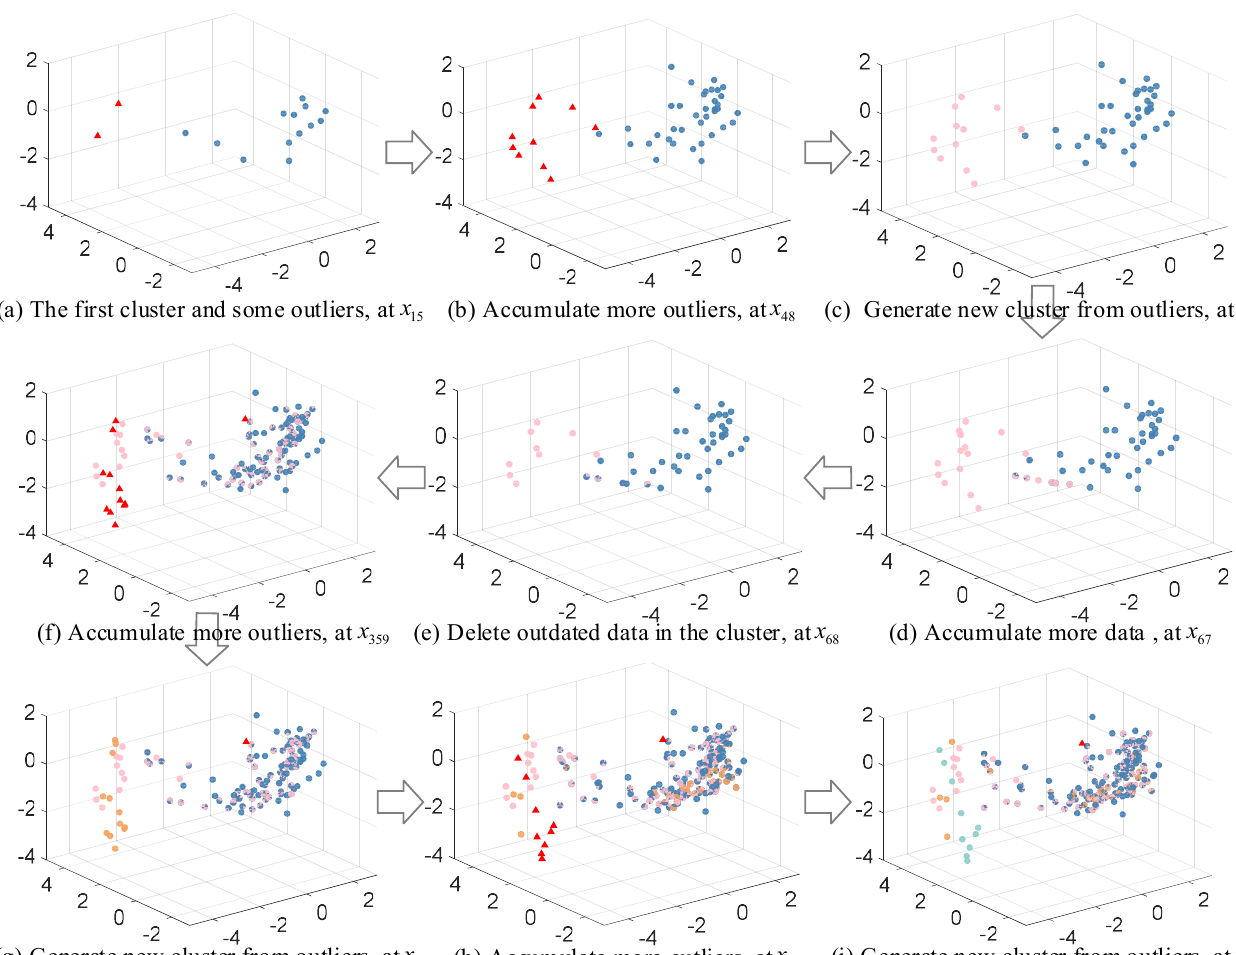
Figure 9. Illustrations of online dynamic clustering for CTC process.